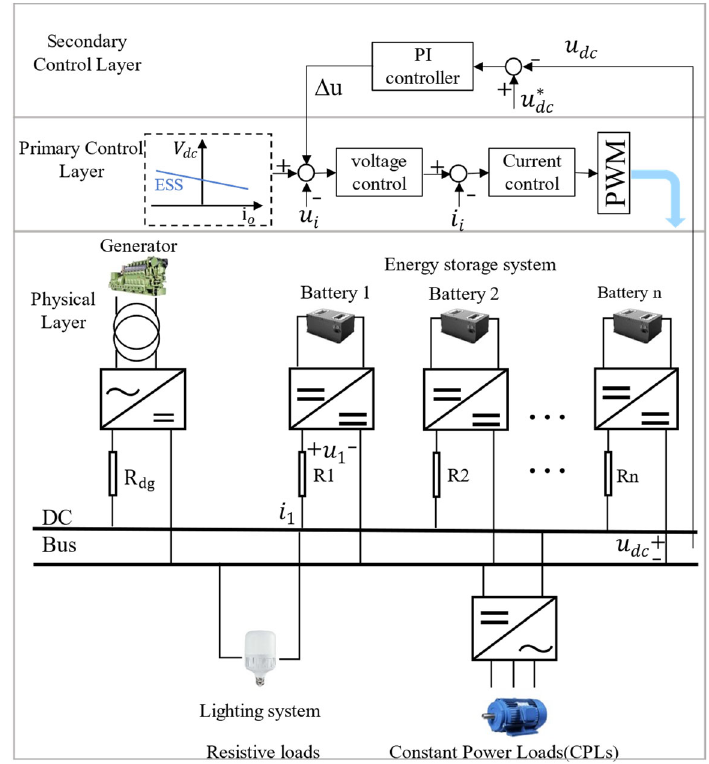
Figure 3. Control Hierarchy of the DC microgrid.